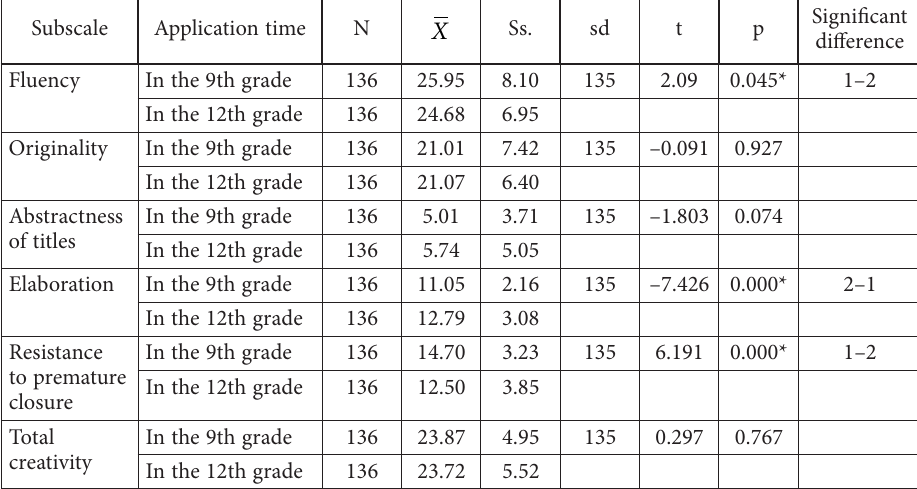
Table 4. Paired-Samples T-Test results of the creativity scores of the adolescents in the 9th and 12th grades (source: created by author) Subscale Application time N X Ss.